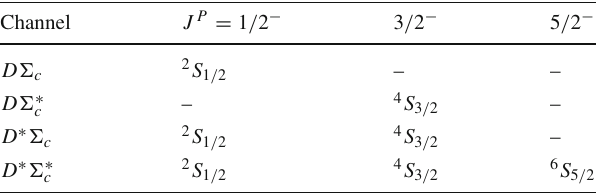
Table 1 S -wave channels in the D (cid:2) c - D (cid:2) ∗ c - D ∗ (cid:2) c - D ∗ (cid:2) ∗ c coupled- channel system. The quantum numbers are given in the spectroscopic form 2 S + 1 L